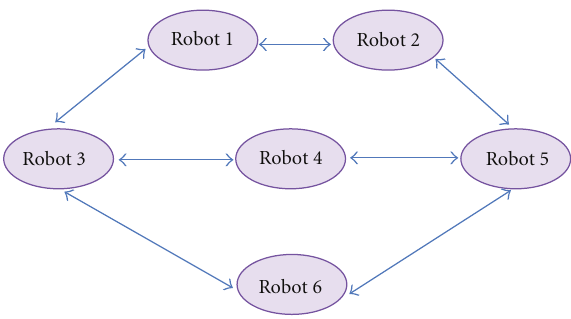
Figure 1: Undirected graph topology structure.